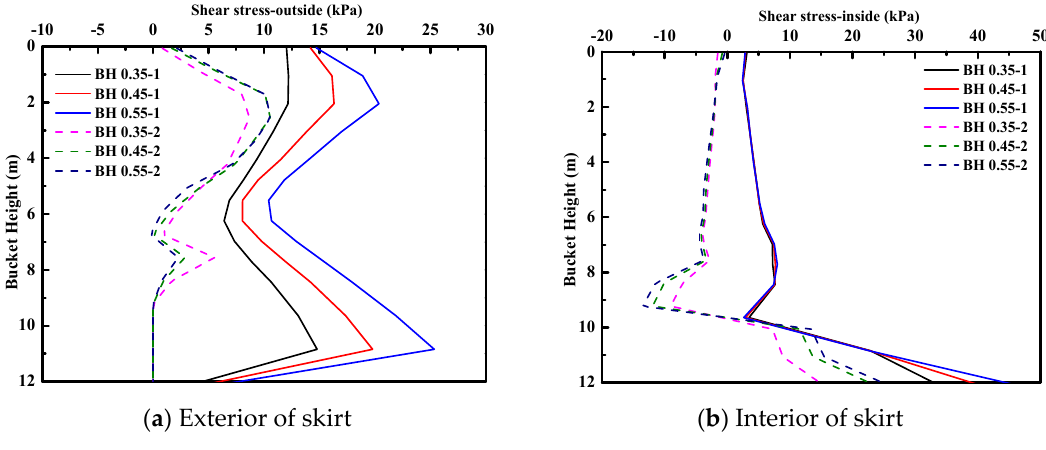
Figure 15. Shear stress of skirt under different friction coefficients.